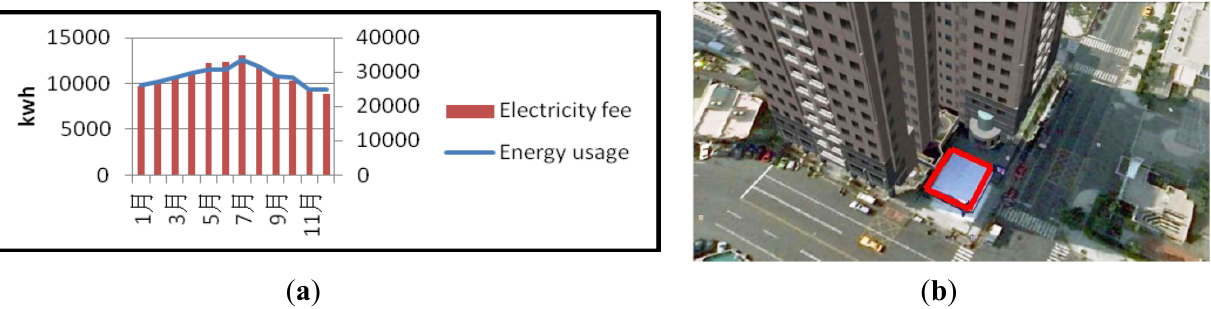
Figure 3. Energy usage index, EUI, is determined by surveying energy usage on the website of Taiwan power company as shown in ( a ) and the store area as shown in ( b ).